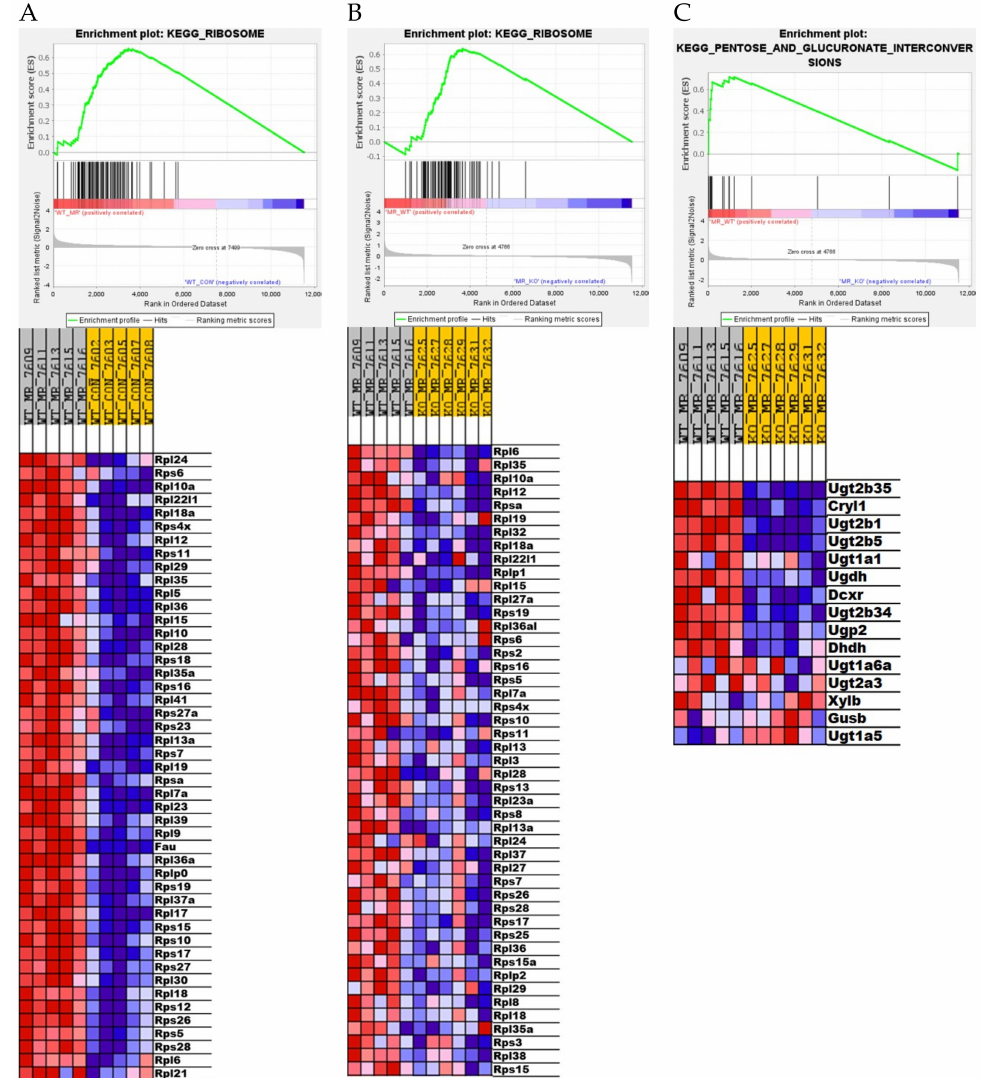
Figure 5. Gene set enrichment analysis (GSEA) of hepatic gene expression in Nfe2l2 fl/fl (WT) and Nfe2l2 fl/(Alb) ( NRF2 KO) mice showing the differential effect of genotype and diet on the top-scoring KEGG Ribosome Drug gene set ( A , B ) and KEGG Pentose and Glucuronate Interconversions gene set ( C ). Enrichment was computed as described in the Material and Methods and the individual contri- butions of pathway genes to the pathway enrichment signal were visualized via enrichment plots depicting the trajectory of a normalized pathway enrichment score against the rank of the pathway genes in the context of the full gene list. Accompanying heat maps present the normalized enrichment scores for individual genes within the gene set [blue = downregulation, red = upregulation, and gray = not significant (FDR > 0.1)]. Panel ( A ) shows the enrichment set for Ribosome pathway for the WT MR to WT Con comparison, panel ( B ) shows the enrichment set for the Ribosome pathway for the WT MR to NRF2 KO MR comparison, while panel ( C ) shows the Pentose and Glucuronate Interconversions enrichment set for the WT MR to NRF2 KO MR